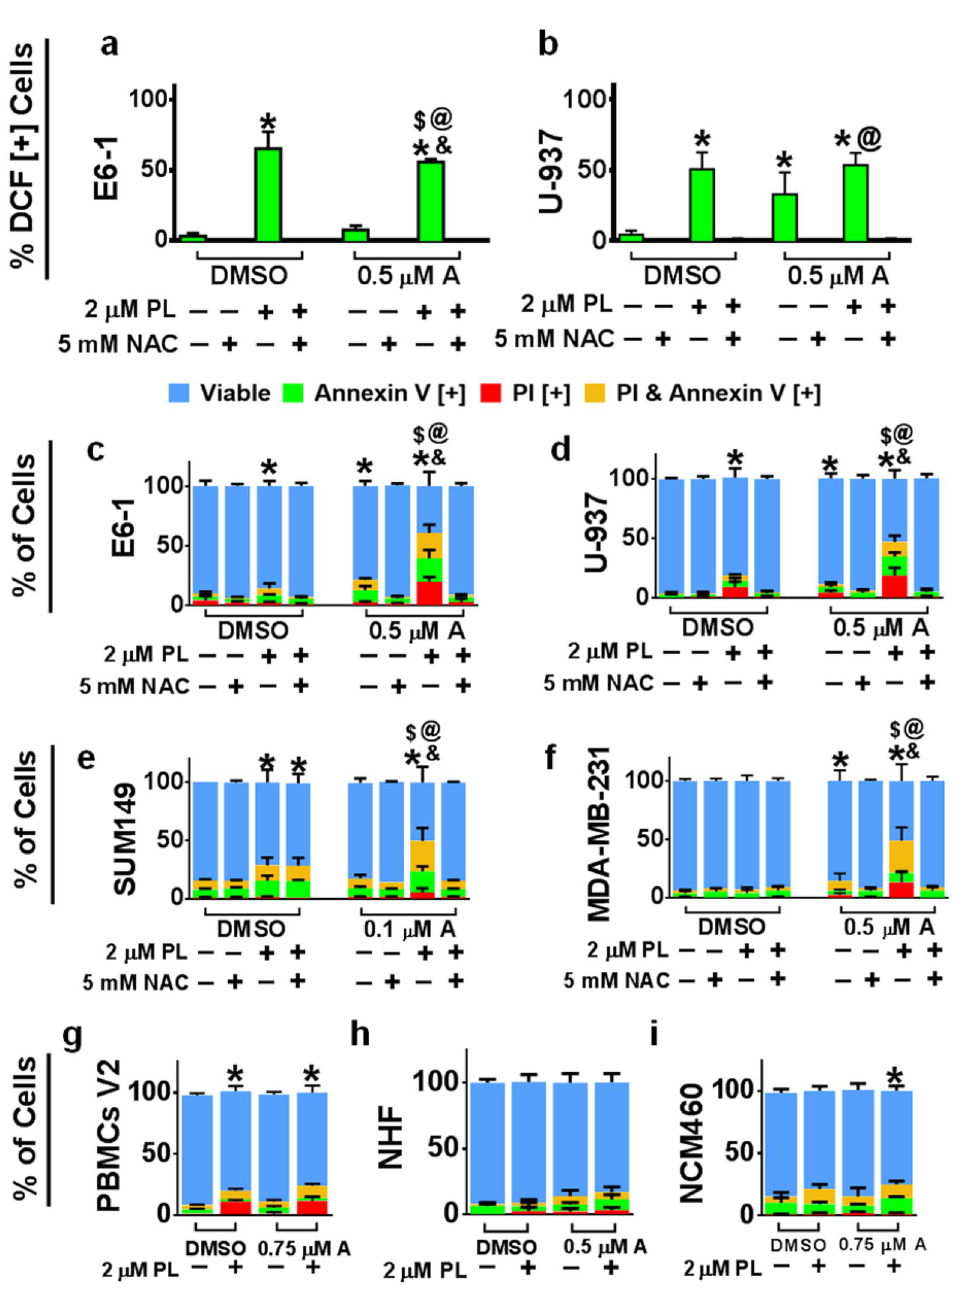
Figure 8. Synergistic Effect of Compound A and PL to Induce Apoptosis Selectively in a Variety of Cancer Cell Lines. ( a,b ) E6-1 and U-937 cell lines were treated with H 2 DCFDA then with Compound A either alone, in combination with NAC or PL alone, or both NAC and PL for 3 hours to monitor the production of ROS. Results were obtained using the image-based cytometry. The Y-axis is representative of percent of cells positive for DCF. ( c–f ) Triple-negative-breast cancer (SUM-149, MDA-MB-231) and blood cancer (E6-1, U-937) cell lines were treated with DMSO, Compound A either alone, in combination with NAC or PL alone, or both NAC and PL for 48 hours. Following treatment, cells were stained for Annexin V and PI. Results were obtained using image-based cytometry. ( g–i ) Peripheral mononuclear blood cells (PBMCs) acquired from a healthy volunteer, normal human fibroblast (NHF) and colon (NCM460) cells were treated with the alone or combinatorial doses for 48 hours. Following treatment, cells were stained for Annexin V and PI. Results were obtained using image-based cytometry. The Y-axis is representative of percent of cells positive for Annexin V (green), PI (red), Annexin V and PI (yellow), or negative for both Annexin V and PI (blue). All graphical values are expressed as a mean ± SD from three independent experiments. Statistical calculations were performed using Two-Way ANOVA multiple comparison ( a–d , g–i ) or One-Way ANOVA multiple comparison ( e,f ). * p < 0.05 vs % viable or DCF [ + ] cells of control (DMSO); @ p < 0.05 vs % viable or DCF [ + ] cells of group treated with PL, NAC, and Compound A; & p < 0.05 vs % viable or DCF [ + ] cells of group treated with Compound A; $ p < 0.05 vs % viable or DCF [ + ] cells of group treated with